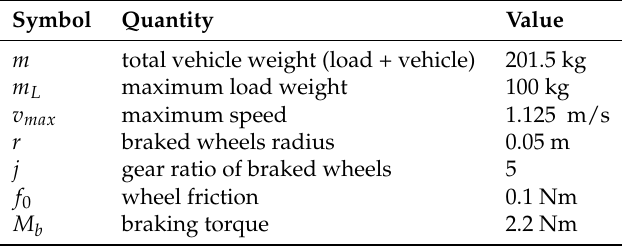
Figure 2. Phollower’s balance system to overcome uneven terrain. Table 1. Basic mechanical parameters of